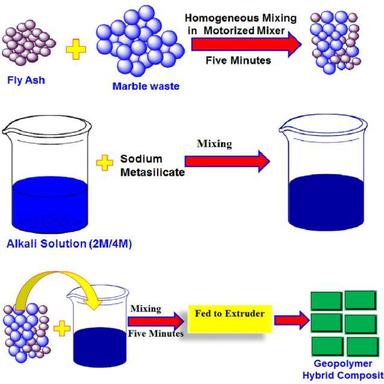
Manufacturing of hybrid geopolymer composite materials.